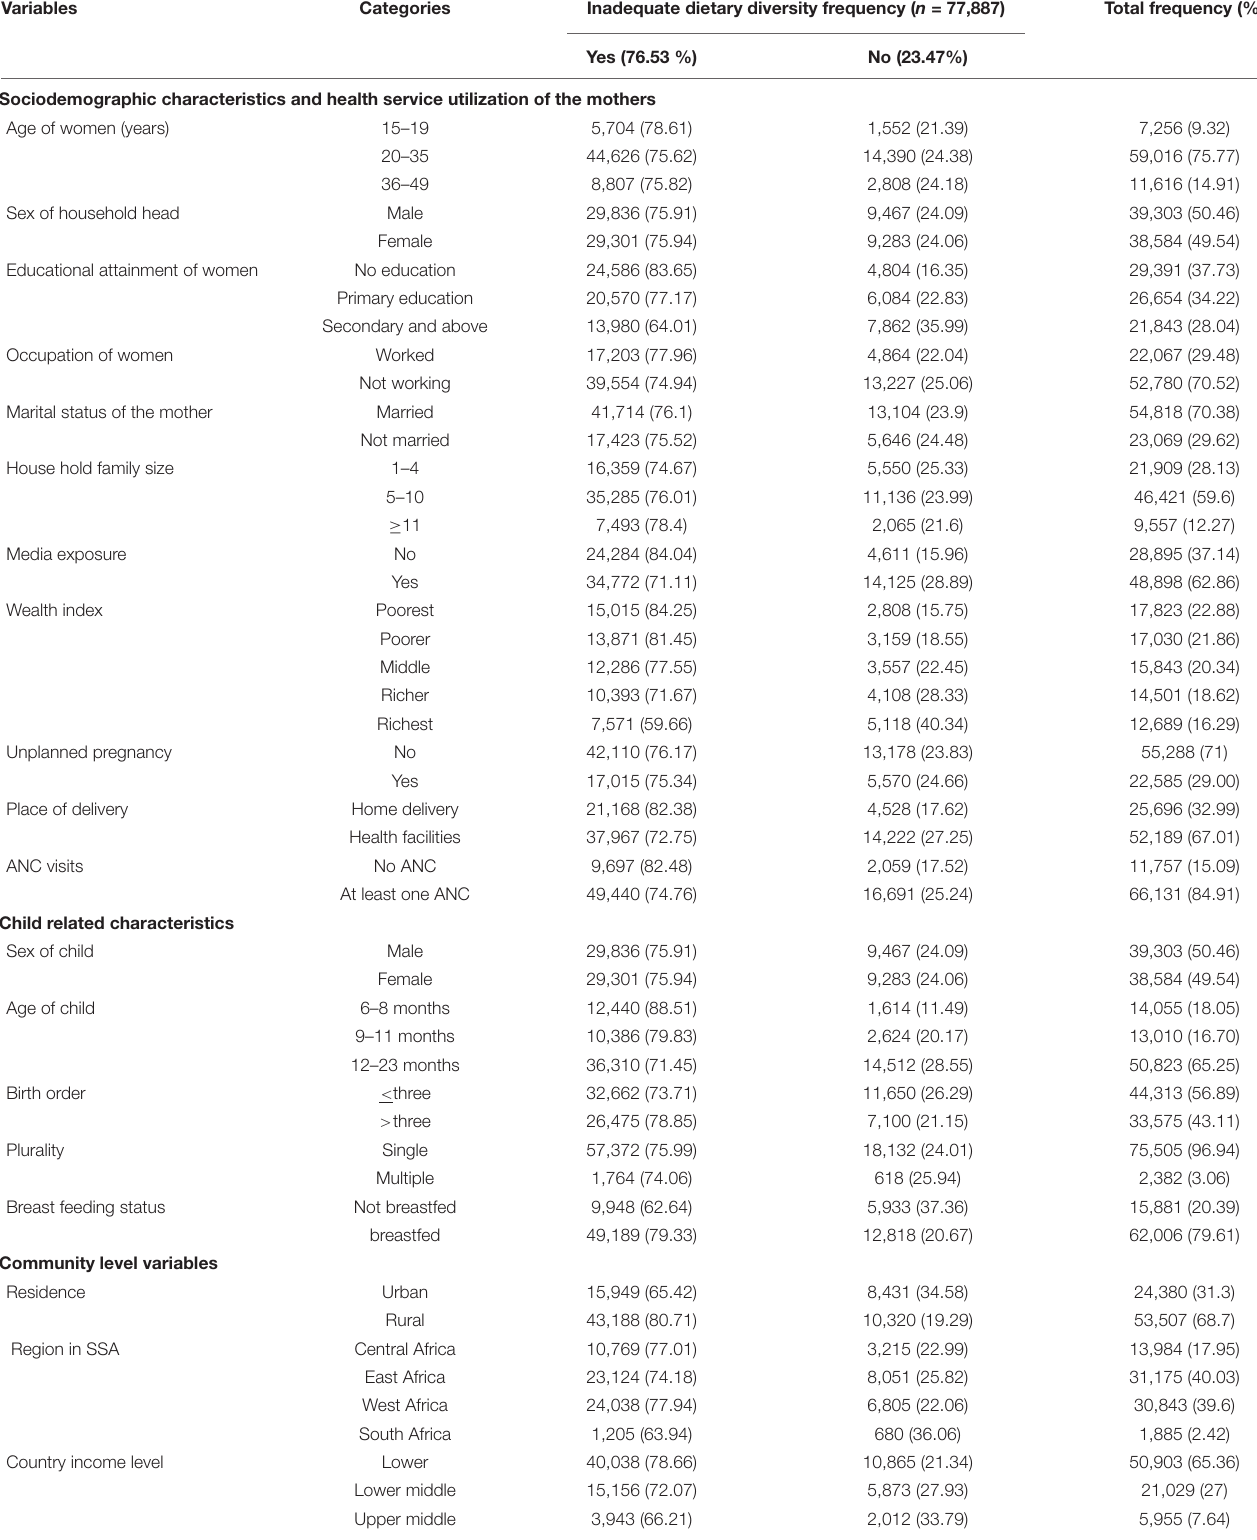
TABLE 4 | Sociodemographic characteristics of the mothers/caregivers and the children in a study of inadequate minimum dietary diversity intake and associated factors among children aged 6–23 months in sub-Saharan Africa: based on 2010–2020 DHS. Variables